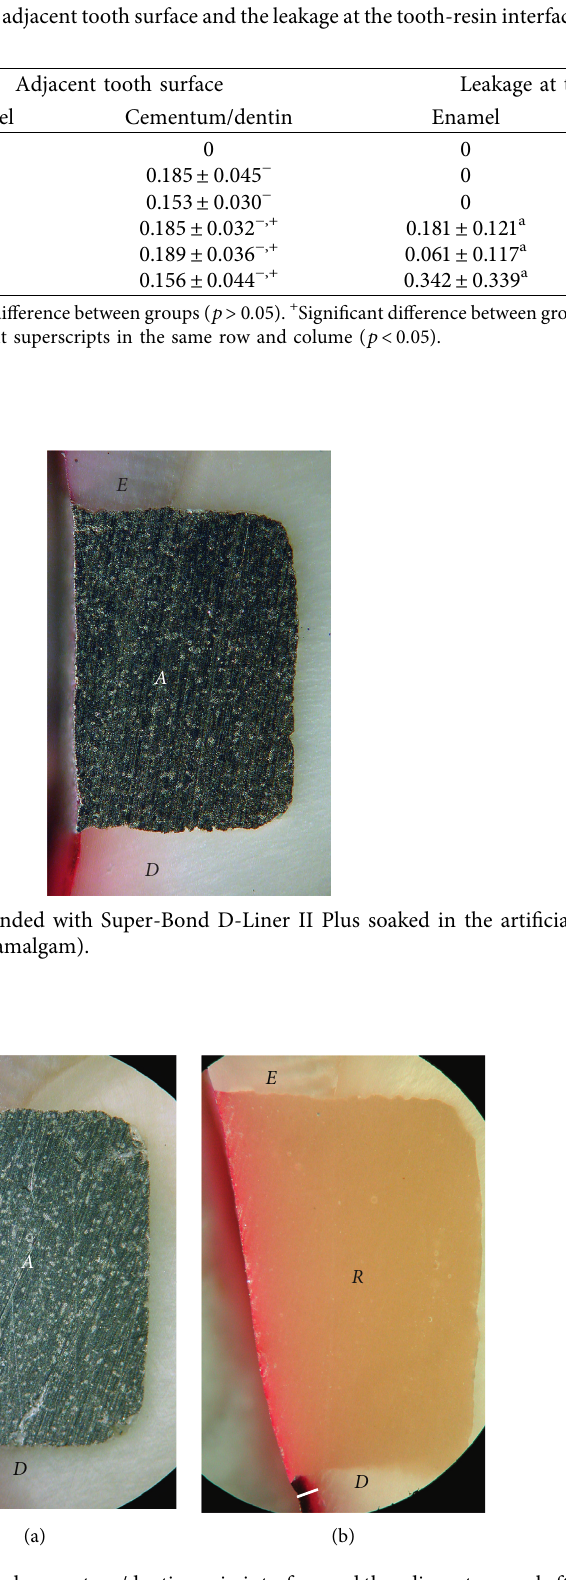
Figure 2: No dye penetration into the enamel- and cementum/dentin-resin interface and the adjacent enamel after artificial caries exposure: (a) amalgam bonded with Super-Bond D-Liner II Plus and (b) resin composite bonded with AQ-Bond (original × 50, E � enamel, A � amalgam, D � dentin, R � resin composite, and a white line � dye penetration into the adjacent